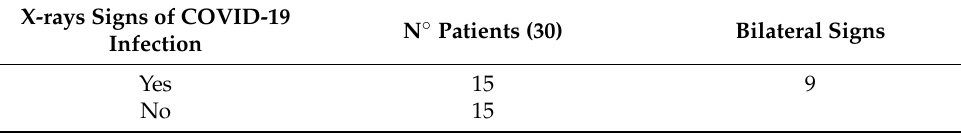
Table 4. Signs of COVID-19 infection in chest X-rays. X-rays Signs of